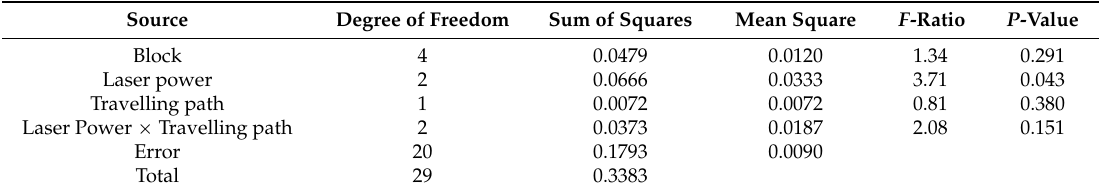
Table 9. ANOVA table for experiment #1-2 (6.6-kW disk laser welding system).